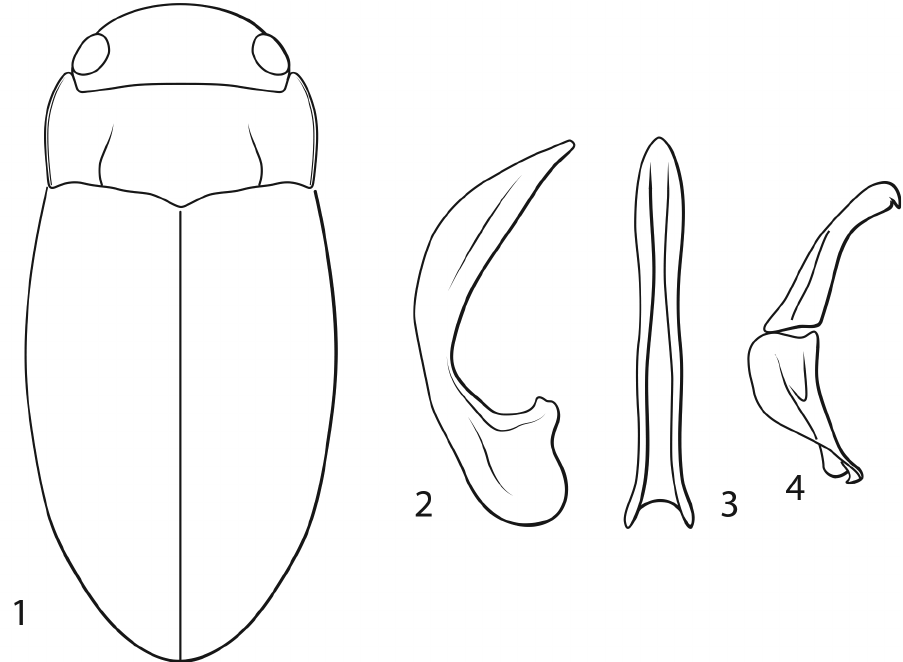
Figures 1–4. Novadessus viracocha sp. n. 1 Dorsal habitus, scale bar = 1.0mm. 2–4 Male genitalia 2 Median lobe, right lateral aspect 3 Median lobe, ventral aspect 4 Right lateral lobe, right lateral